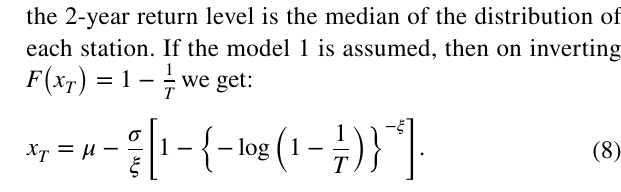
Fig. 5 Plot of annual maximum precipitation data for 1969 to 2011 with trend fitted by lowness smoother